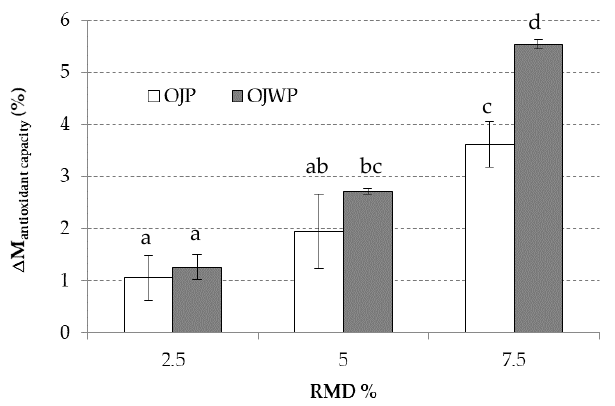
Figure 3. Mean values and standard deviation of antioxidant capacity (AC) variation of pasteurized orange juice (OJP and OJWP) with 2.5, 5, and 7.5 RMD%. Letters indicate homogeneous groups established by the ANOVA ( p < 0.05) for each parameter analyzed. OJP, orange juice with pulp; OJWP, orange juice without